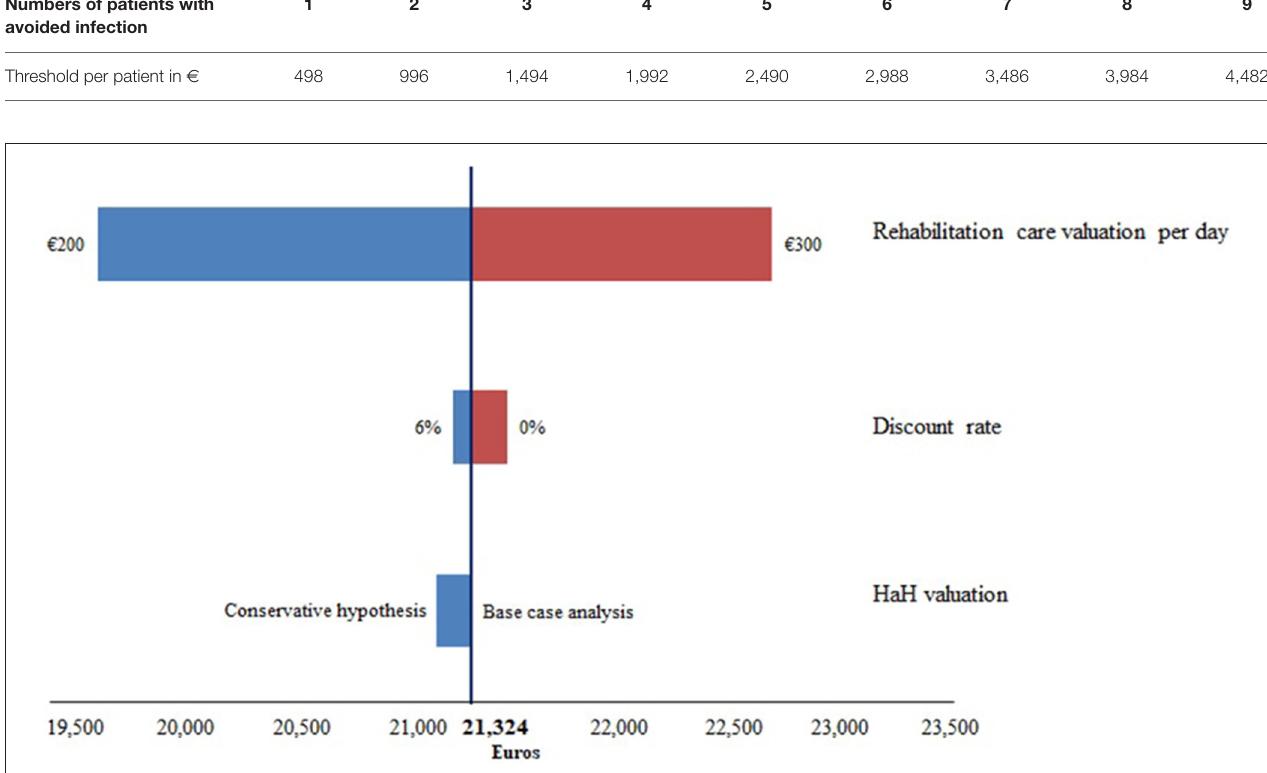
FIGURE 1 | Tornado diagram on the impact of methodological choices on the mean cost of care per